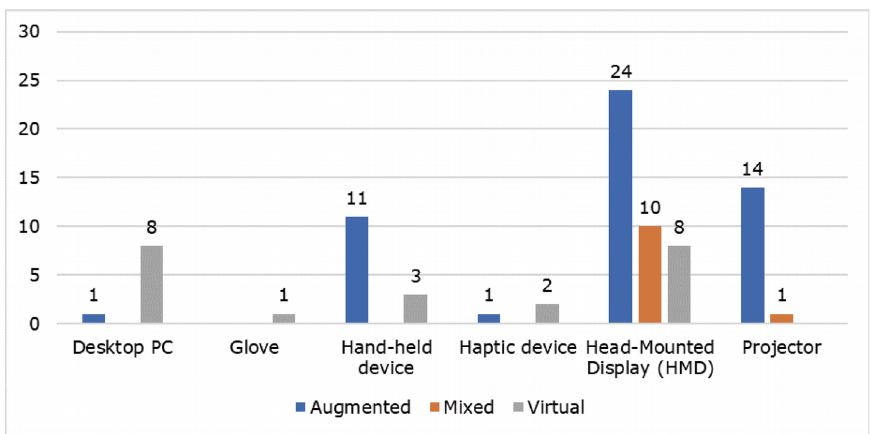
Figure 6. Type of devices for augmented, virtual and mixed